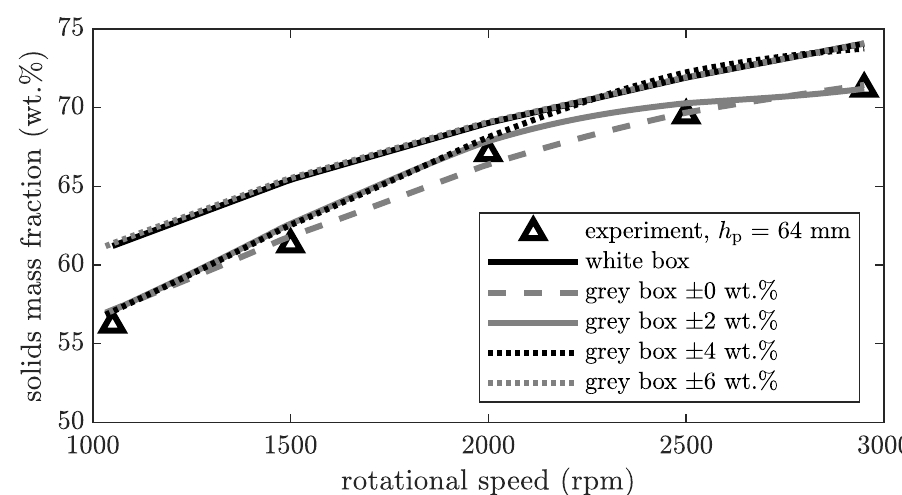
Figure 4. Solids mass fraction of the cake for different rotational speeds, and variation of cake trust interval at a constant volumetric flow rate of ˙ V in = 2000Lh − 1 for CC1.